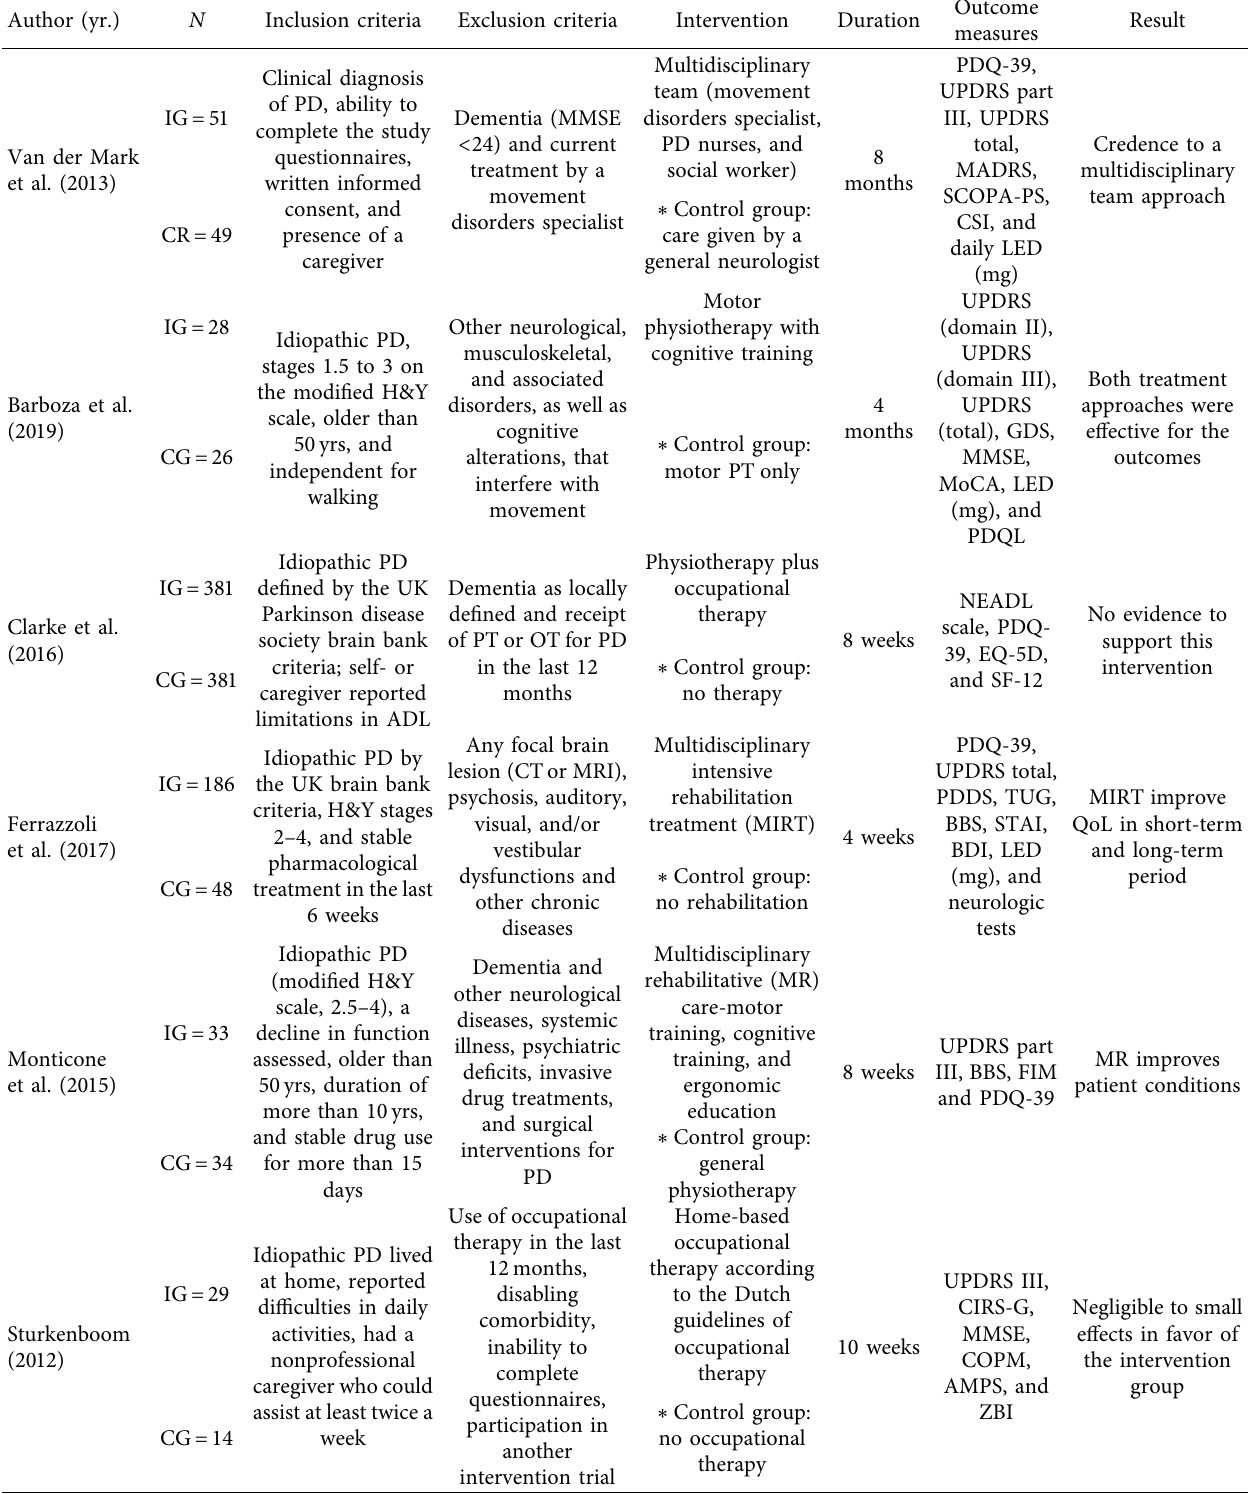
Table 1: Characteristics of the included